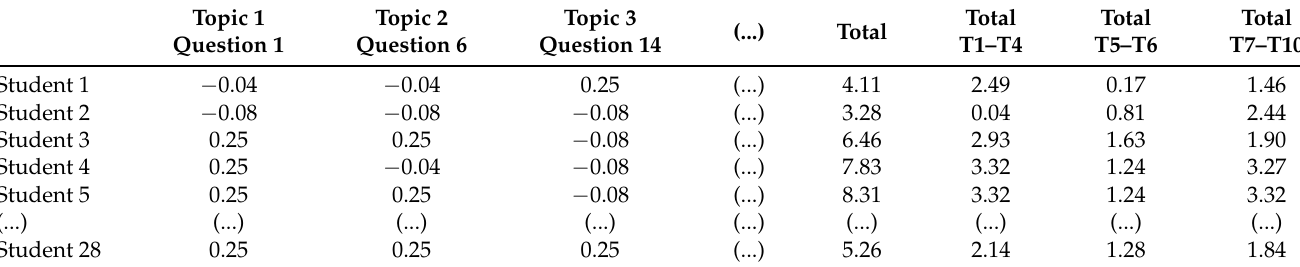
Table 11. Sample of grades by topics and questions. Year